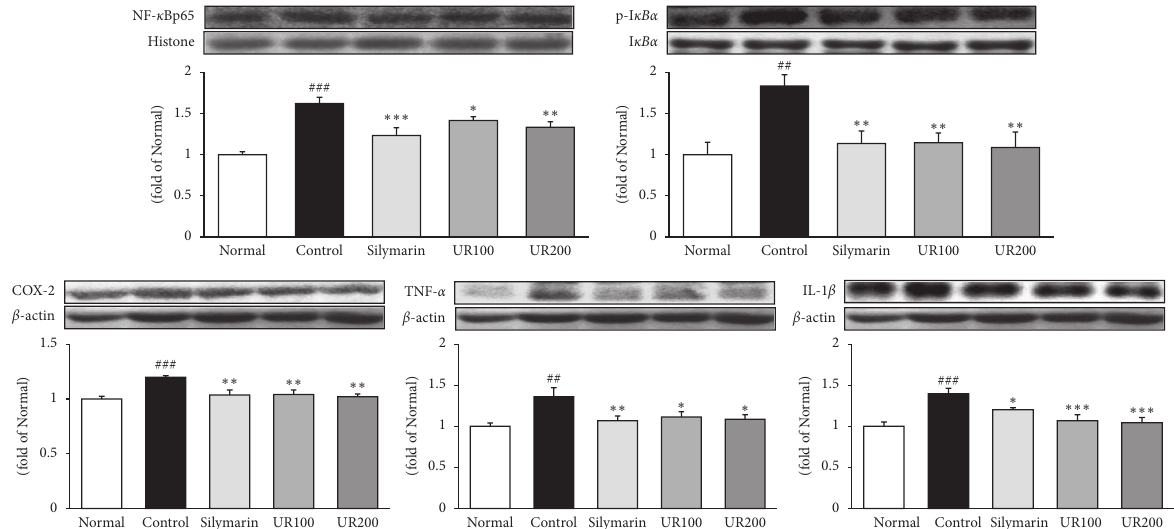
Figure 5: Effect of UR on inflammatory proteins. Effects of UR on the expression levels of p-I κ B α , NF- κ Bp65, COX-2, TNF- α , and IL-1 β by the Western blotting assay. Data are expressed as the mean ± SEM ( n � 7). Significance: ## p < 0 . 01 and ### p < 0 . 001 vs. the normal group and ∗ p < 0 . 05, ∗∗ p < 0 . 01, and ∗∗∗ p < 0 . 001 vs. the ALI control